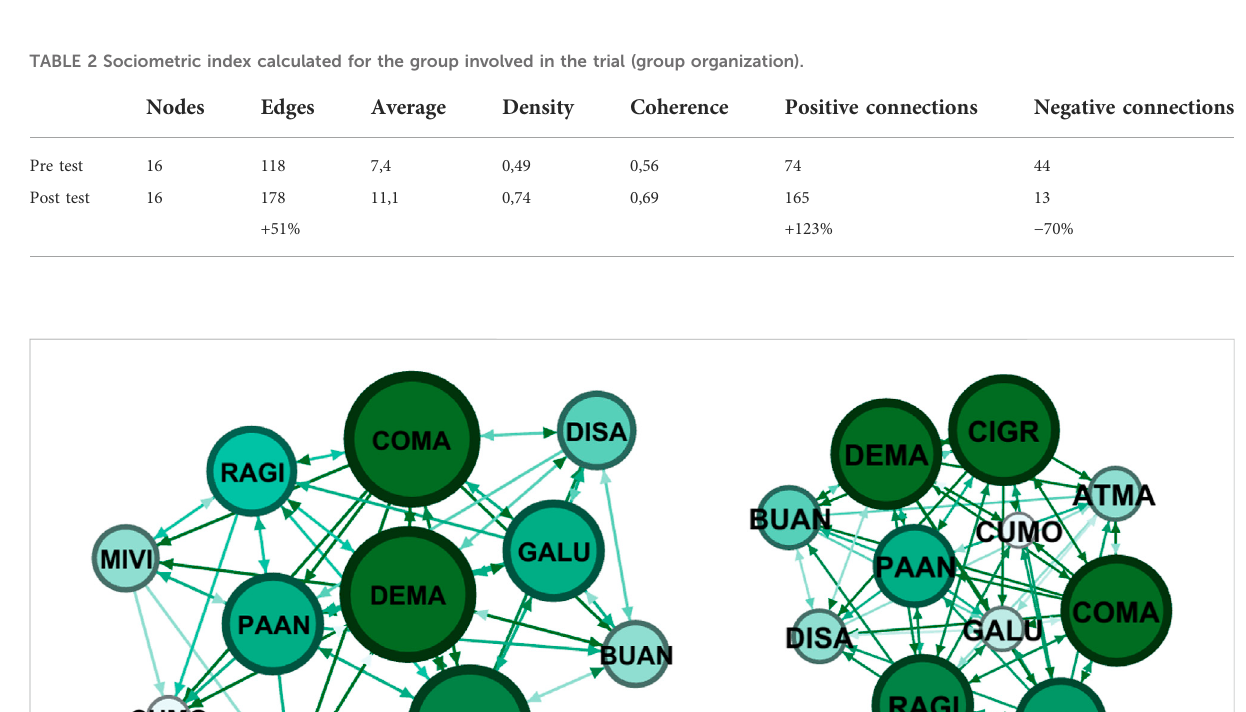
TABLE 3 Sociometric index calculated for the control group (affective/relational). Nodes Edges Average